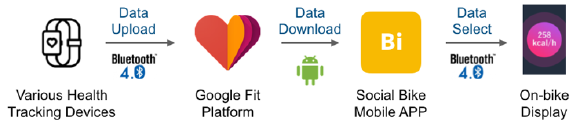
Figure. 1. Schematic of SocialBike's technical system.